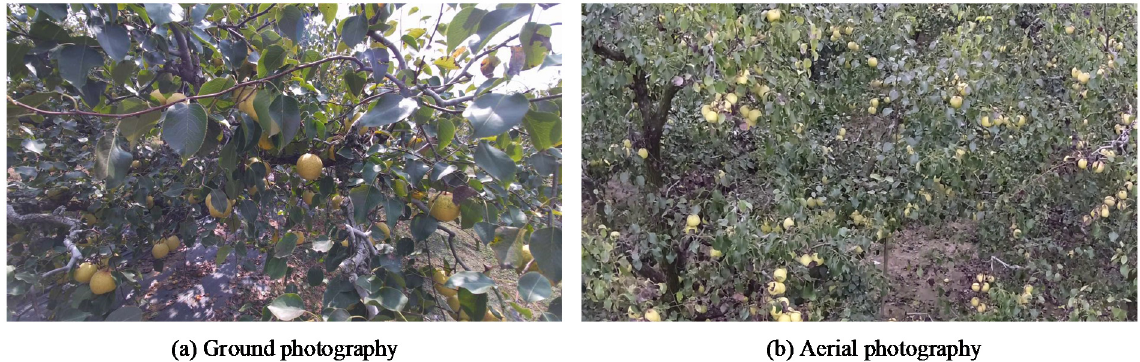
Figure 1. Pears in orchards from the ground and aerial viewpoints. ( a ) Image captured by the cam- era mounted on the ground tripod, ( b ) Image captured by the camera mounted on the UAV plat- form